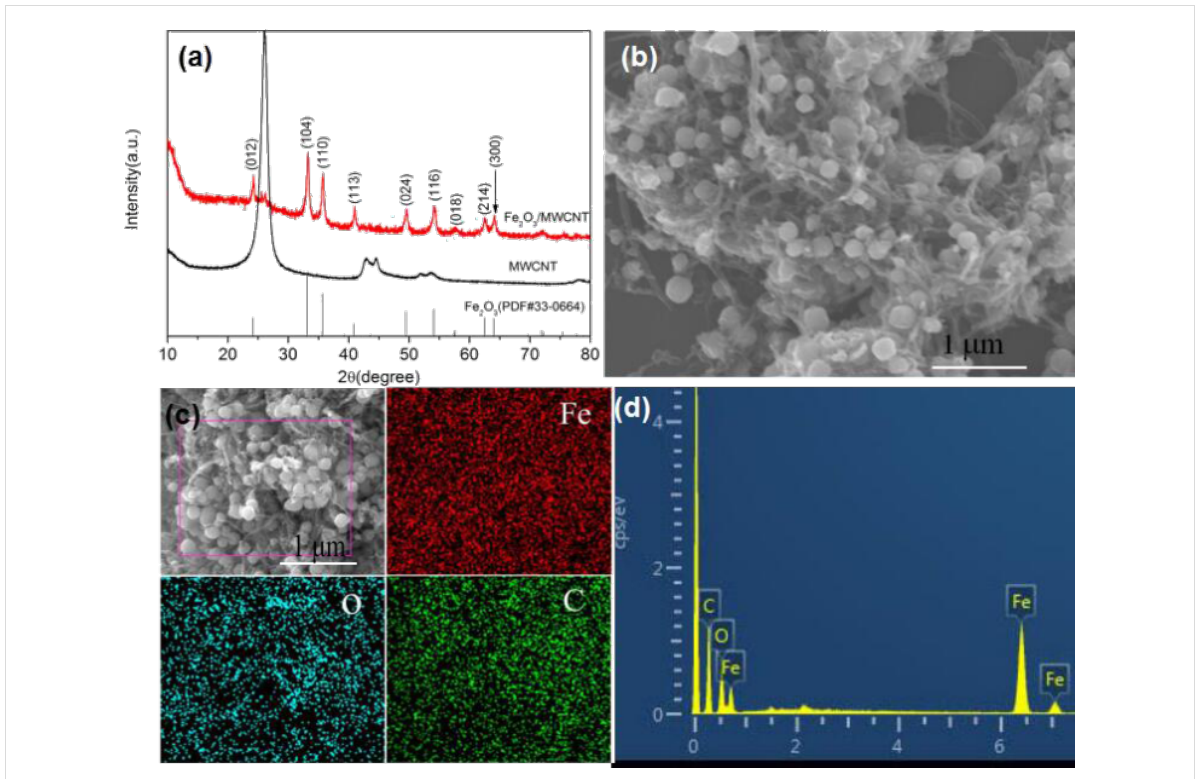
Figure 1: Fe 2 O 3 /COOH-MWCNT composites: (a) XRD patterns; (b) SEM image; (c) and (d) energy-dispersive X-ray analysis (EDX).